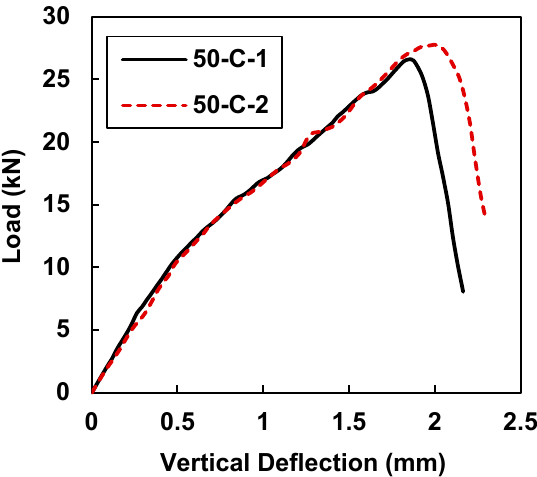
Figure 10. Load vs. midspan deflection for samples 50-C-1 and 50-C-2.